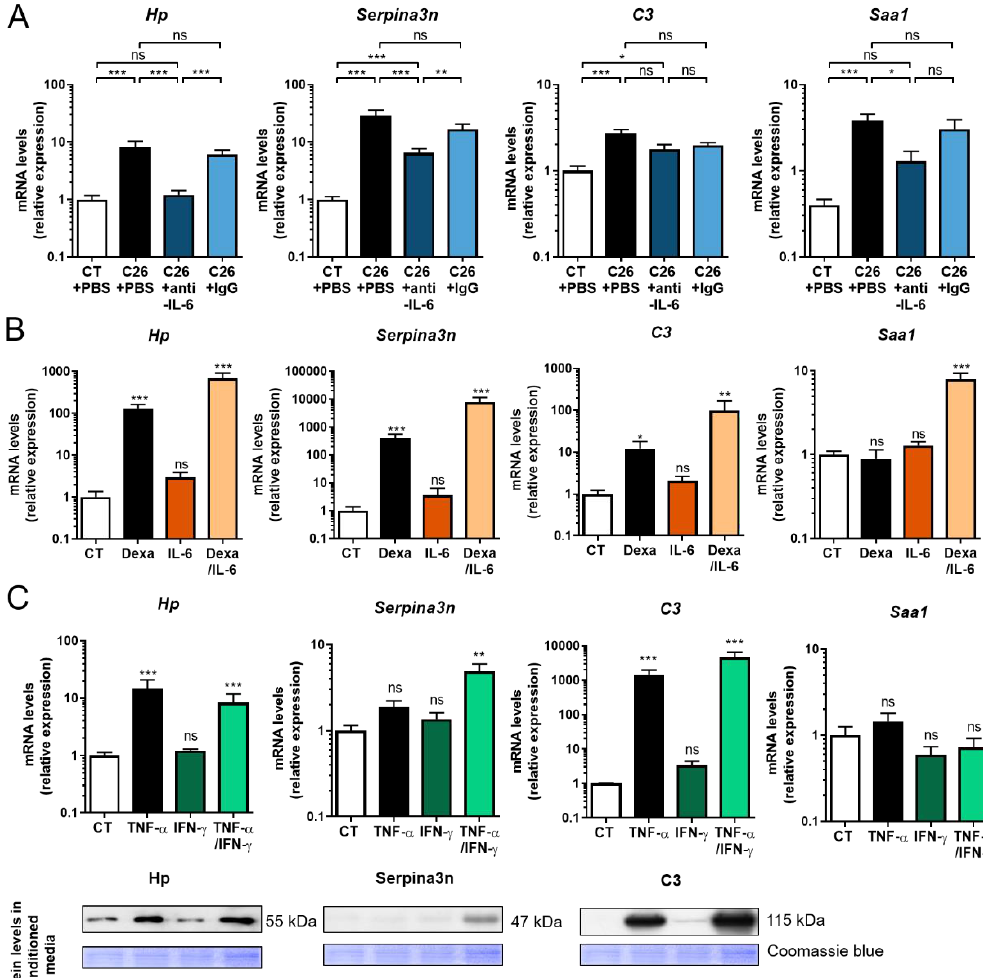
Figure 5. Muscular expression of APR is regulated by IL-6 in vivo and by glucocorticoids / pro inflammatory cytokines in vitro. ( A ) Anti-IL-6 antibodies prevent the increased muscular production of acute phase reactants (APR) in C26 male mice. Hp , Serpina3n , C3 , and Saa1 mRNA levels in the GC muscle of mice injected with C26 cells alone (C26 + PBS) or in combination with rat anti-murine IL-6 antibodies (C26 + anti-IL-6) or with rat IgG1 isotype control (C26 + IgG) or injected with vehicle alone (CT + PBS). (B-C) Glucocorticoids and proinflammatory cytokines stimulate the production of acute phase reactants (APR) by skeletal muscle cells. Hp , Serpina3n , C3 , and Saa1 mRNA levels in C 2 C 12 myotubes exposed for 48 h to ( B ) IL-6 (25 ng / mL), dexamethasone (Dexa; 10 − 6 M) alone or in combination. ( C ) Hp , Serpina3n , C3 , and Saa1 mRNA and protein levels in C 2 C 12 myotubes exposed for 48 h to TNF- α (5 ng / ml), IFN- γ (5 ng / mL) alone or in combination. Coomassie blue staining was used as loading control. Data are reported as means ± SEM ( n = 3–8 / group). * p < 0.05, ** p < 0.01, and *** p < 0.001. ns: no statistically significant when compared to CT. Please find the whole western blot of Figure 5C in the Figure S12.